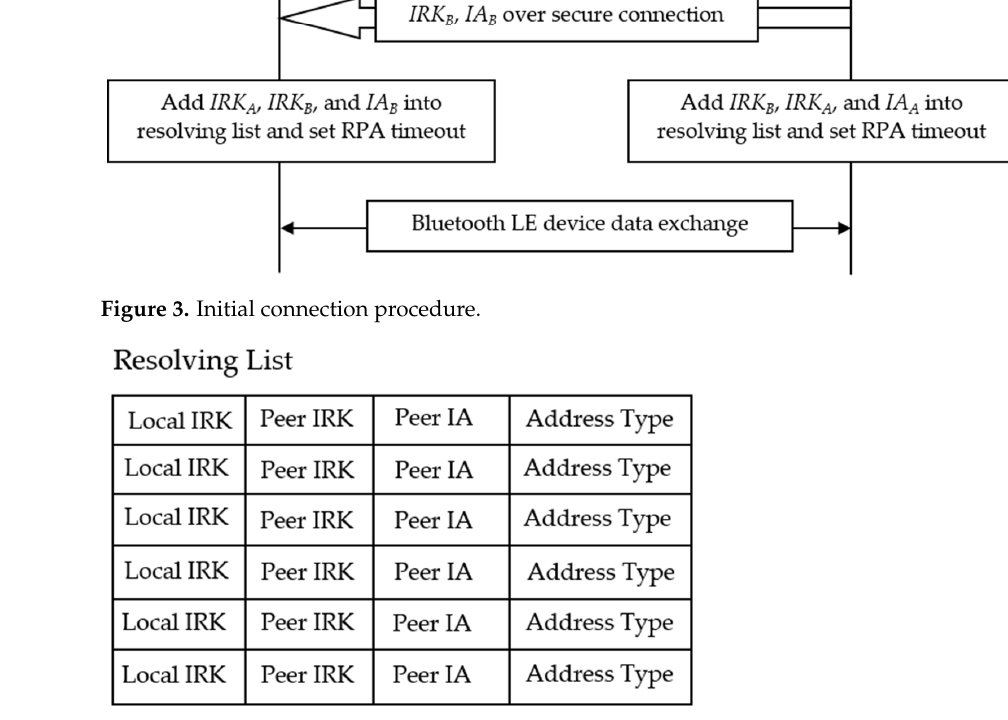
Figure 4. Logical structure of resolving list.